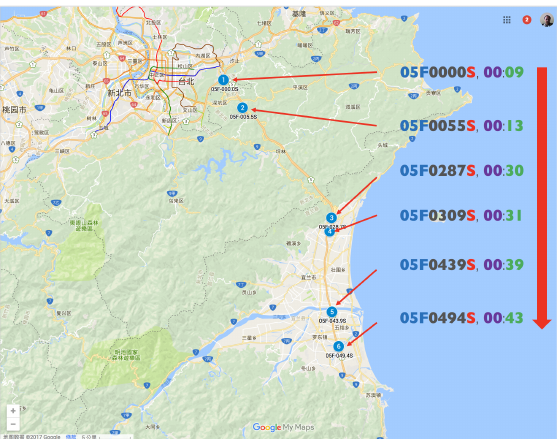
Figure 7. Example: one travel time pattern in southern (S) direction from “05F0000S” to “05F0494S” (Travel Time = 34 min).